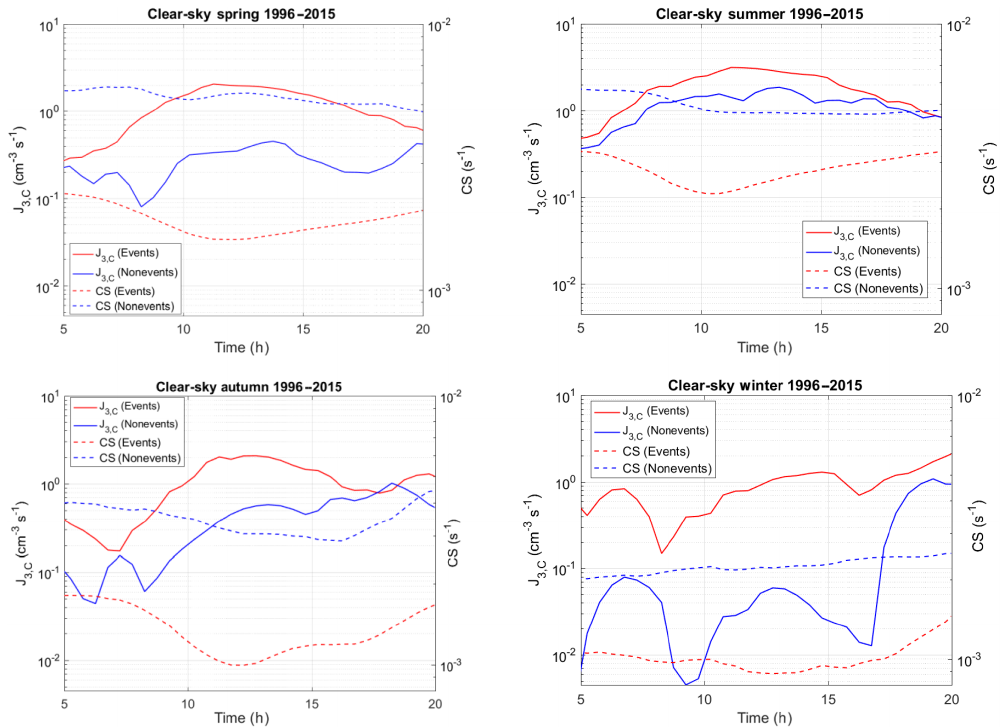
Figure 10. Diurnal cycle of median values of calculated formation rate of 3nm particles ( J 3 ,C ) and condensation sink (CS) during different seasons for clear-sky events and nonevents.